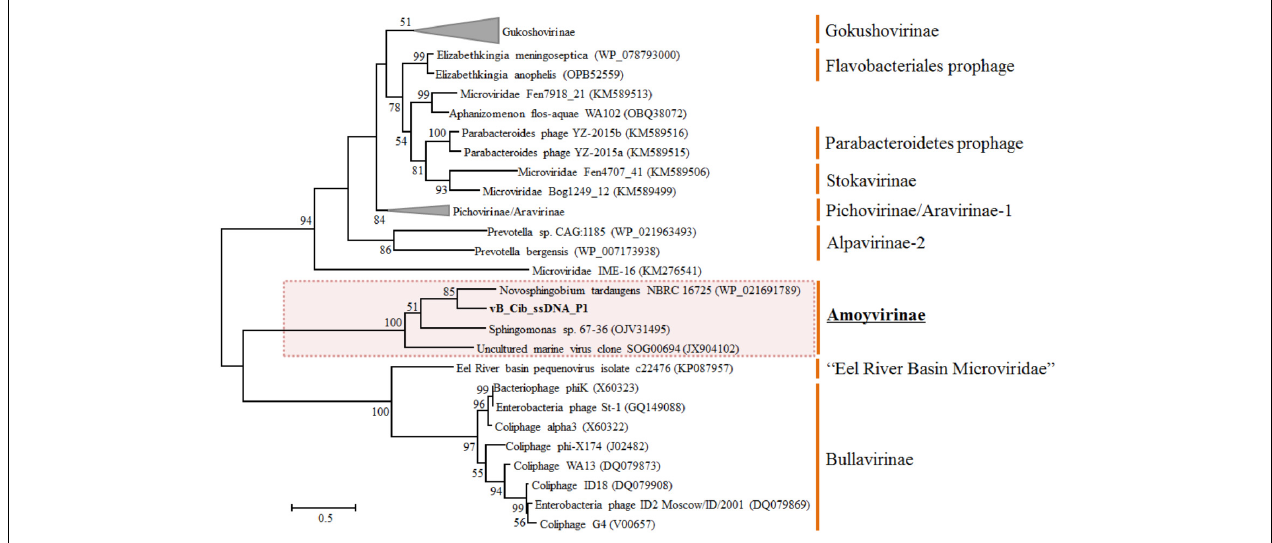
FIGURE 3 | Unrooted maximum-likelihood phylogenetic tree based on the full-length major capsid inferred amino-acid sequences in Microviridae genomes. Bootstrap percentages from maximum-likelihood (100 replications) are shown. The scale bar represents a distance of 0.2 substitutions per site.